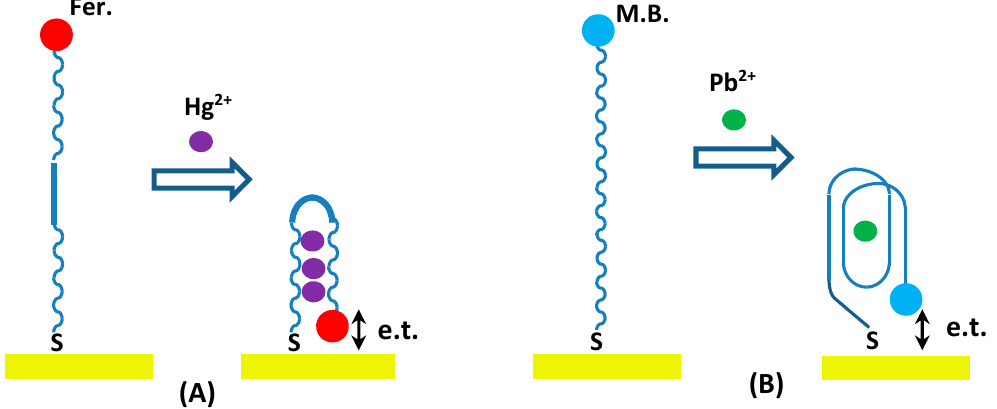
Figure 1. Schematic diagram of electrochemical detection of heavy metal ions Hg 2+ ( A ) and Pb 2+ ( B ) using redox-labelled aptamers.